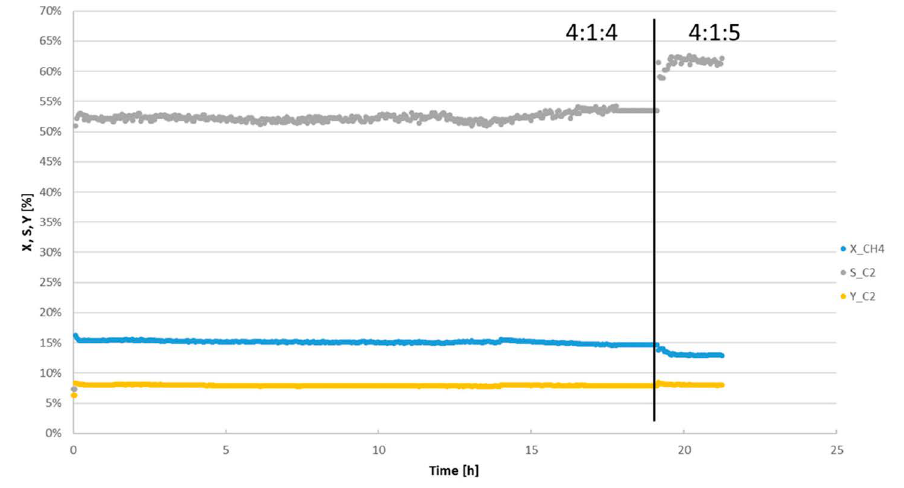
Figure 10. Second catalyst charge. Catalytic testing of 3D structured catalyst corresponding to reaction conditions at the XRD-CT run with longer calcination time and time on stream at 840 ◦ C